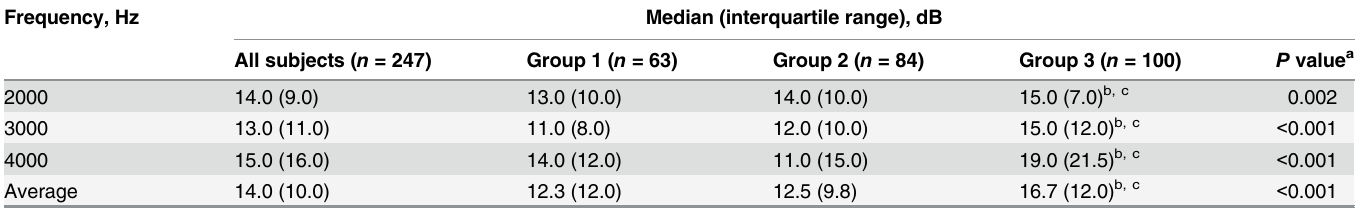
a Compared by Kruskal-Wallis test among group 1, group 2 and group 3. b P